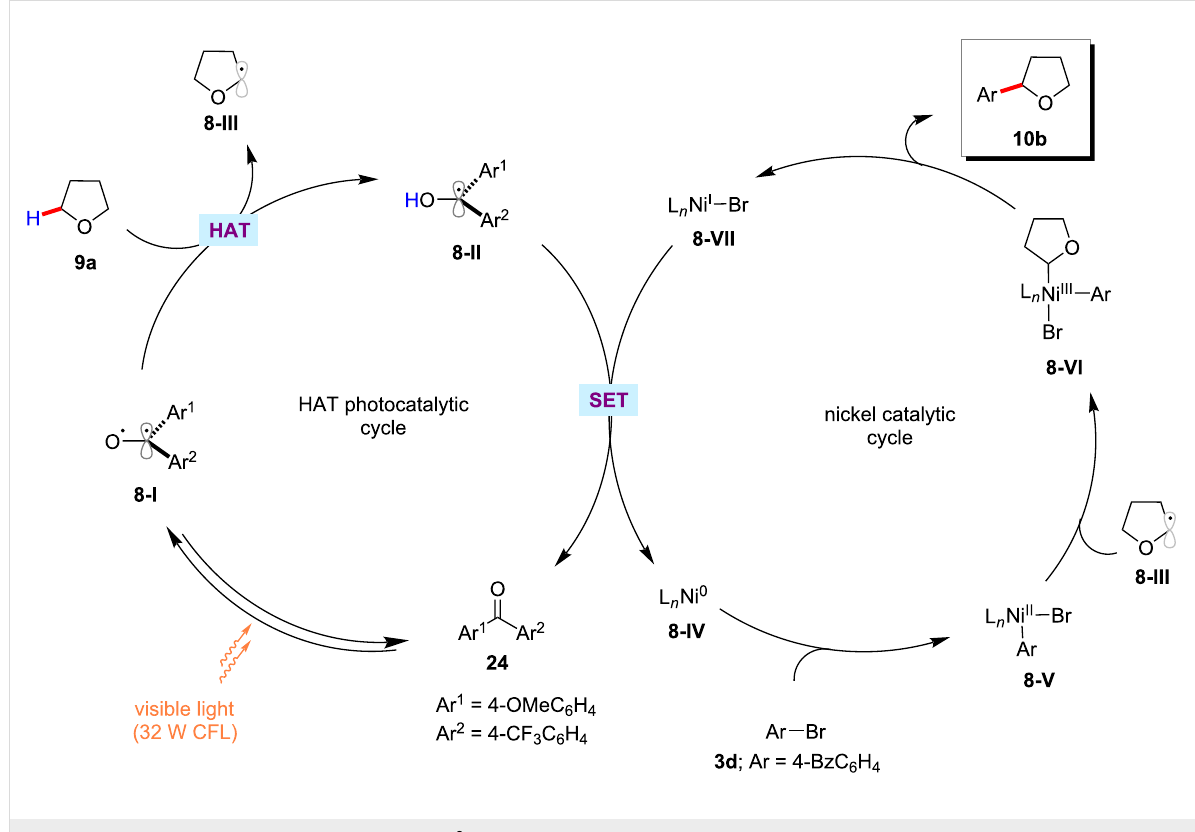
Figure 8: Proposed mechanism for photochemical C(sp 3 ) ‒ H arylation by the synergy of ketone HAT catalysis and nickel catalysis.